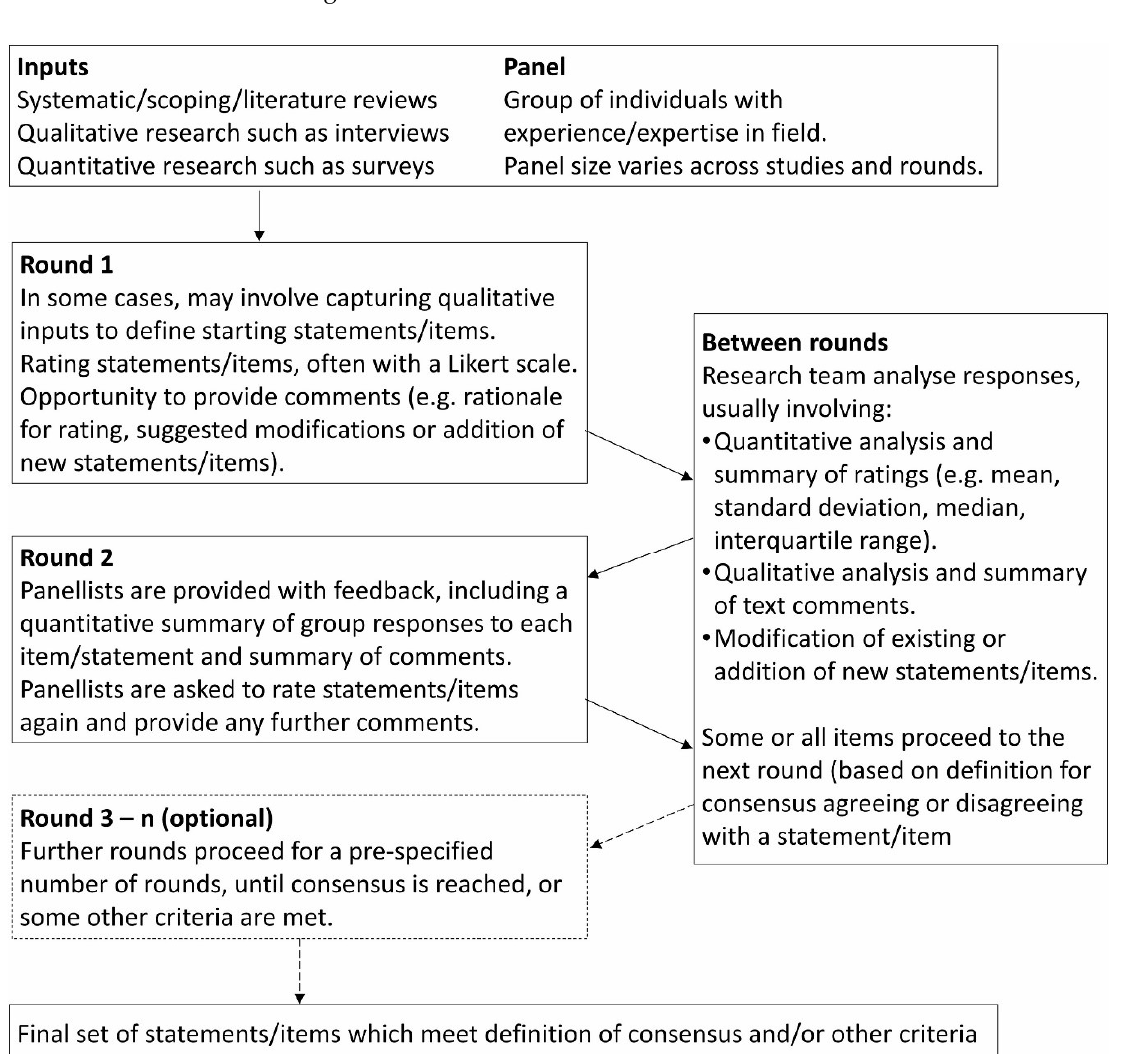
Figure 13. Step-by-step process of Delphi technique, adopted from [113].